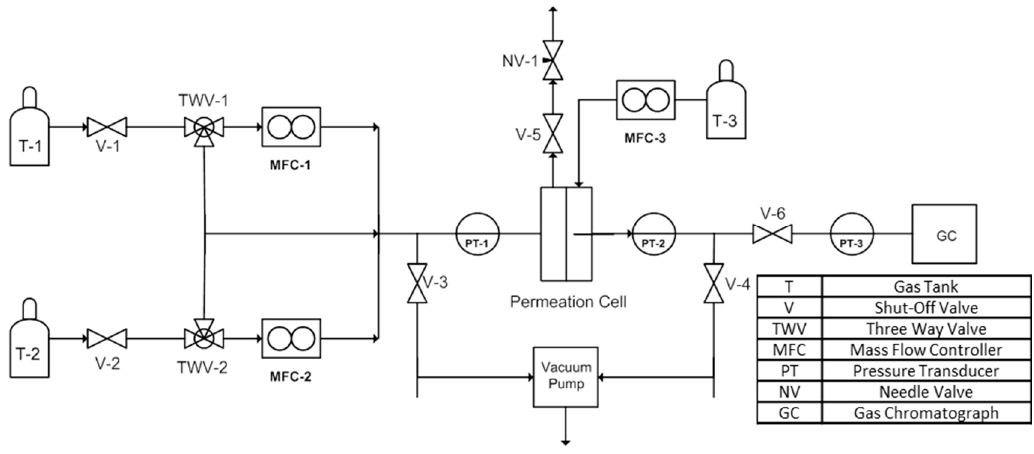
Membranes 2019 , 9 , x FOR PEER REVIEW